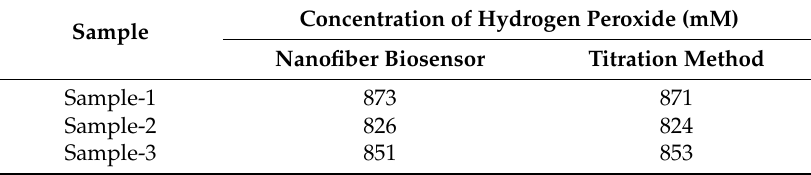
Table 2. Determination results of hydrogen peroxide in real